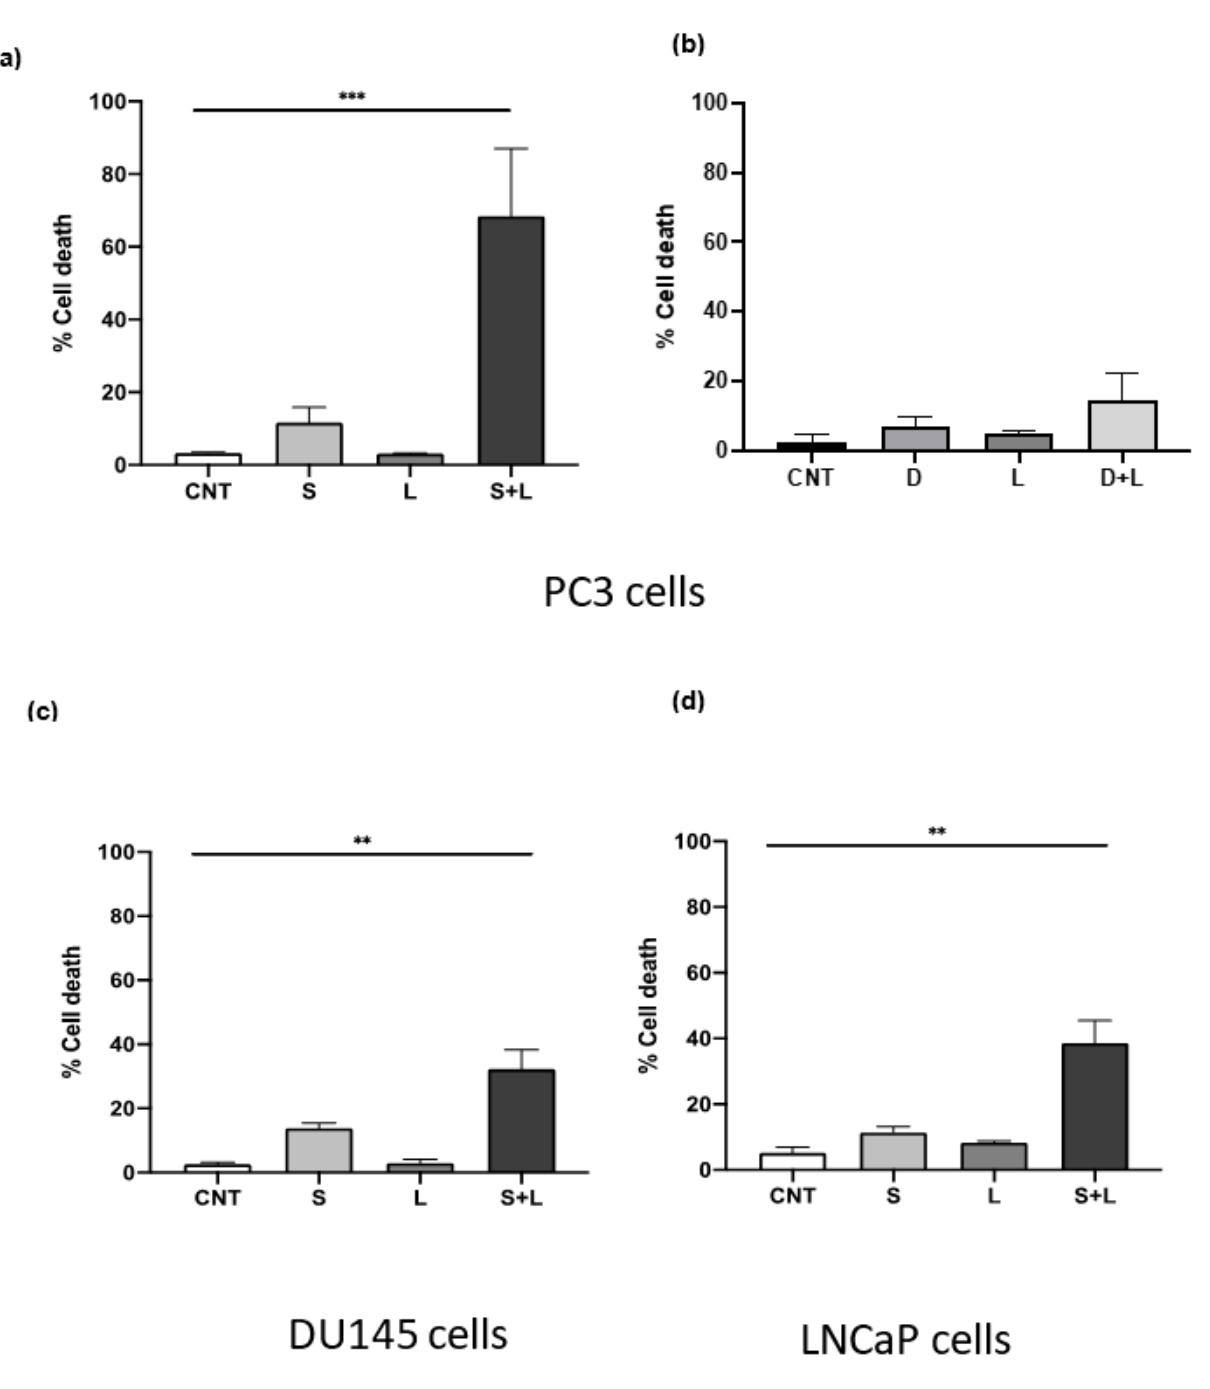
Figure 4. Siramesine and lapatinib induce cell death in PC3 cells. PC3 cells were treated with ( a ) siramesine (S, 10 µ M) and lapatinib (L, 0.5 µ M) or desipramine (D, 10 µ M) and ( b ) Lapatinib (L, 0.5 µ M) for 24 h and stained with the fluorescent dye Trypan blue (0.4%) and analyzed by flow cytometry. ( c ) DU145 cells or ( d ) LNCaP cells were treated as above 24 h. An increase in fluorescence indicates an increase in cell death. Results are representative of at least three independent replicates ( n = 3). ** Represents statistical significant differences between control and combinational treatment (S + L) with a value of p < 0.05. For all other treatments there was no significant difference. To determine whether increased in cell death was specific to lapatinib or if other tyrosine kinase inhibitors increase cell death, PC3 cells were treated with 10 µ M sorafenib or 10 µ M gefitinib. The results showed increased cell death occurred with siramesine in